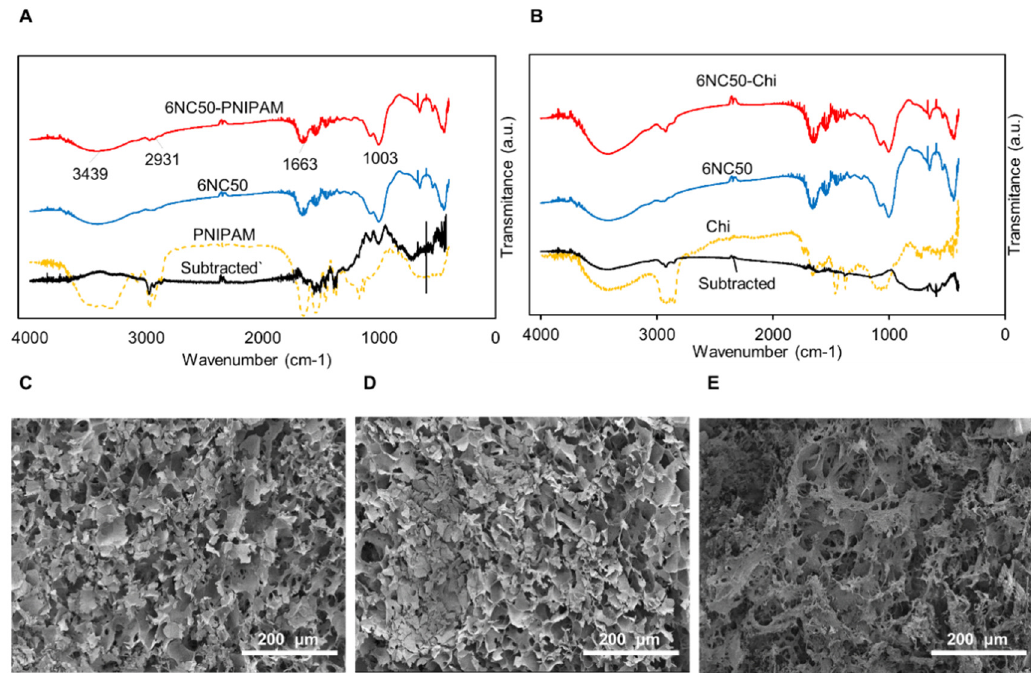
Figure 2. Chemical composition and microstructure of the shear-thinning gel. ( A ) FTIR spectra of 6NC50 shear-thinning gel loaded with PNIPAM particles; ( B ) FTIR spectra of 6NC50 shear-thinning gel loaded with Chi particles. SEM images illustrate the effect of adding PNIPAM and Chi particles on the microstructure of shear thinning gel ( C ) 6NC50; ( D ) 6NC50-PNIPAM; ( E ) 6NC50-Chi.